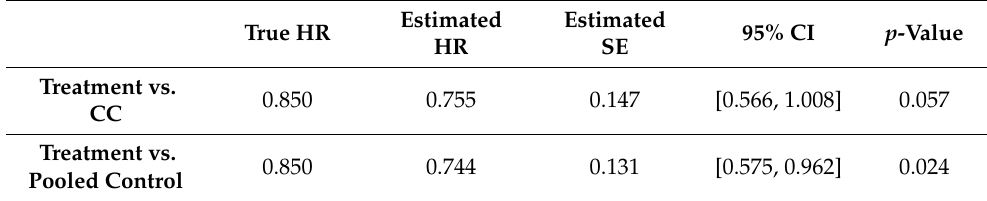
Table 1. Estimated HR, SE, 95% CI, and p -values for Figure 3a,b. Estimated Estimated 95% CI p -Value True HR HR SE Treatment vs. 0.850 0.755 0.147 [0.566, 1.008] 0.057 CC Treatment vs. 0.850 0.744 0.131 [0.575, 0.962] Pooled Control